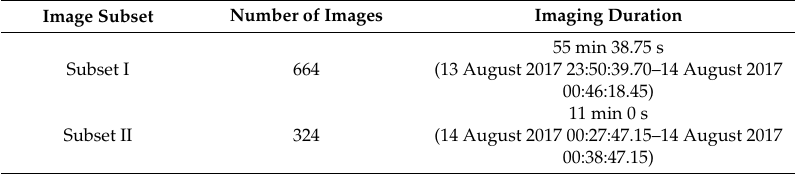
Figure 4. Predefined subsets of acquired VHR images: ( a ) locations and altitudes; and ( b ) acquisition times of the selected images acquired from altitude ranges between 200 and 400 m, designated as Subset I; ( c ) locations and altitudes; and ( d ) acquisition times of the selected images acquired from altitudes higher than 1000 m, designated as Subset II. Table 4. Details for image subsets selected from helicopter-borne VHR